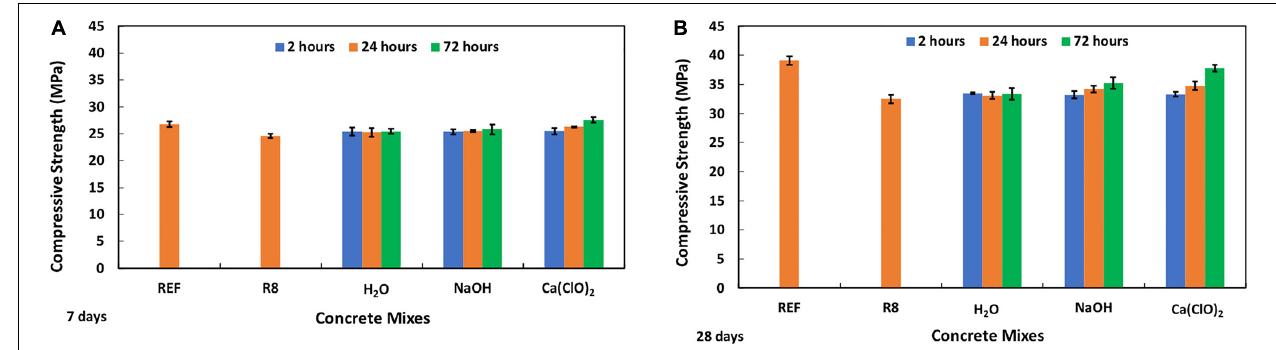
FIGURE 6 | Compressive strength of concrete mixes at (A) 7 days and (B) 28 days testing.